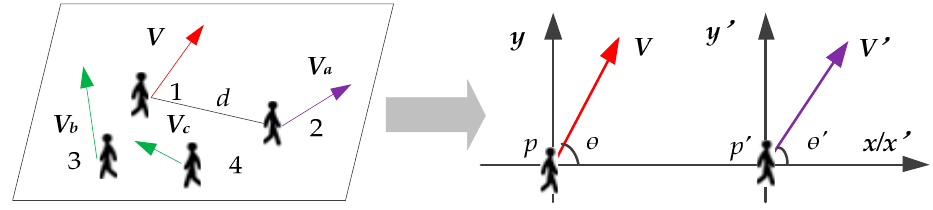
Figure 1. Distribution of pedestrians at a certain moment. The arrows represent the walking direction of pedestrians, the red color represents the target pedestrian, i.e., pedestrian 1, other colors represent other individuals in the crowd, V represents the walking speed, and d represents the distance between pedestrian 1 and pedestrian 2. The right picture shows the relative motion coordinate system of p ′ to p .